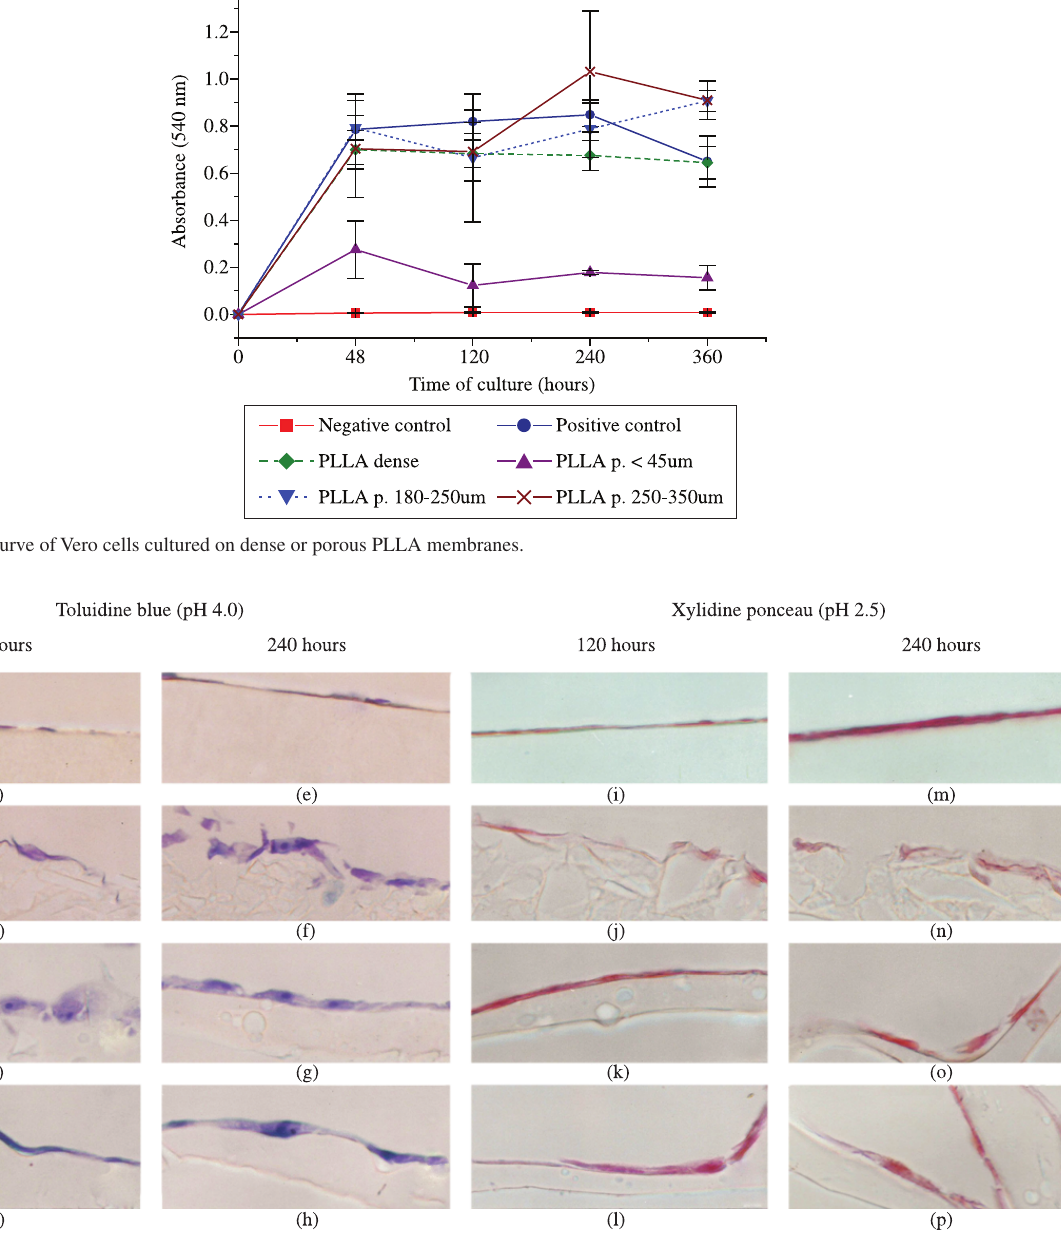
Figure 4. Cytochemical analysis of cells cultured on different PLLA membranes. Cells cultured on a dense PLLA membrane for 120 hours (a and i) and 240 hours (e and m). Cells cultured on a PLLA membrane with a pore diameter less than 45 µ m for 120 hours (b and j) and 240 hours (f and n). Cells cultured on a PLLA membrane with a pore diameter of 180-250 µ m for 120 hours (c and k) and 240 hours (g and o). Cells cultured on a PLLA membrane with a pore diameter of 250-350 µ m for 120 hours (d and l) and 240 hours (h and p). From a) to h), samples were stained with Toluidine blue, pH 4.0, and from i) to p) samples were stained with Xylidine ponceau, pH